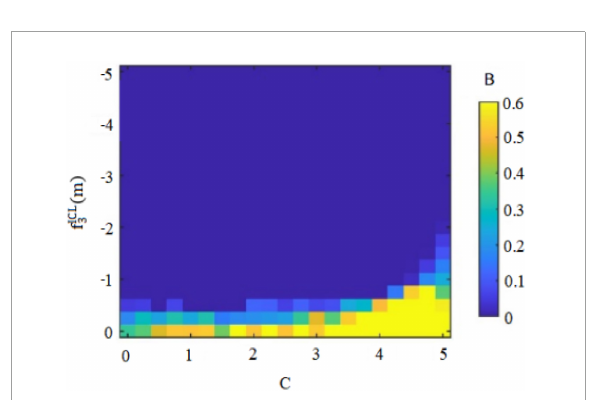
FIGURE5 Psychological capital, perceived benefit, and deviant innovative behavior (low risk-taking